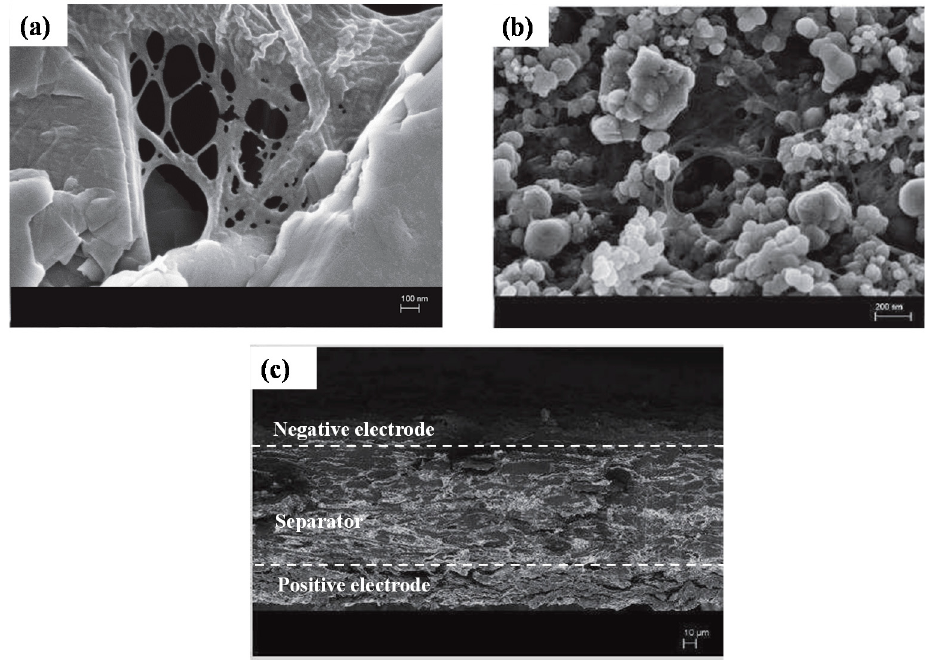
Figure 4. Field emission scanning electron microscopy (FESEM) images of surface electrodes and the printed battery. ( a ) Network structure between the graphite (GP) platelets and cellulose nanofibers (CNF) (mag: 50,000 × , beam acceleration voltage: 3 kV, working distance 4.1 mm). ( b ) The same network structure has been observed for positive electrodes between lithium iron phosphate (LFP)/carbon black (CB) particles and the CNF network (mag: 20,000 × , beam acceleration voltage: 3 kV, working distanceWD: 4.1 mm). ( c ) The cross-section of the full printed battery is showed with a three-layer structure corresponding to the separator and the positive and negative electrodes, and delaminations between the separator and the positive electrode are displayed (mag: 200 × , beam acceleration voltage: 3 kV, working distanceWD: 4.2 mm).